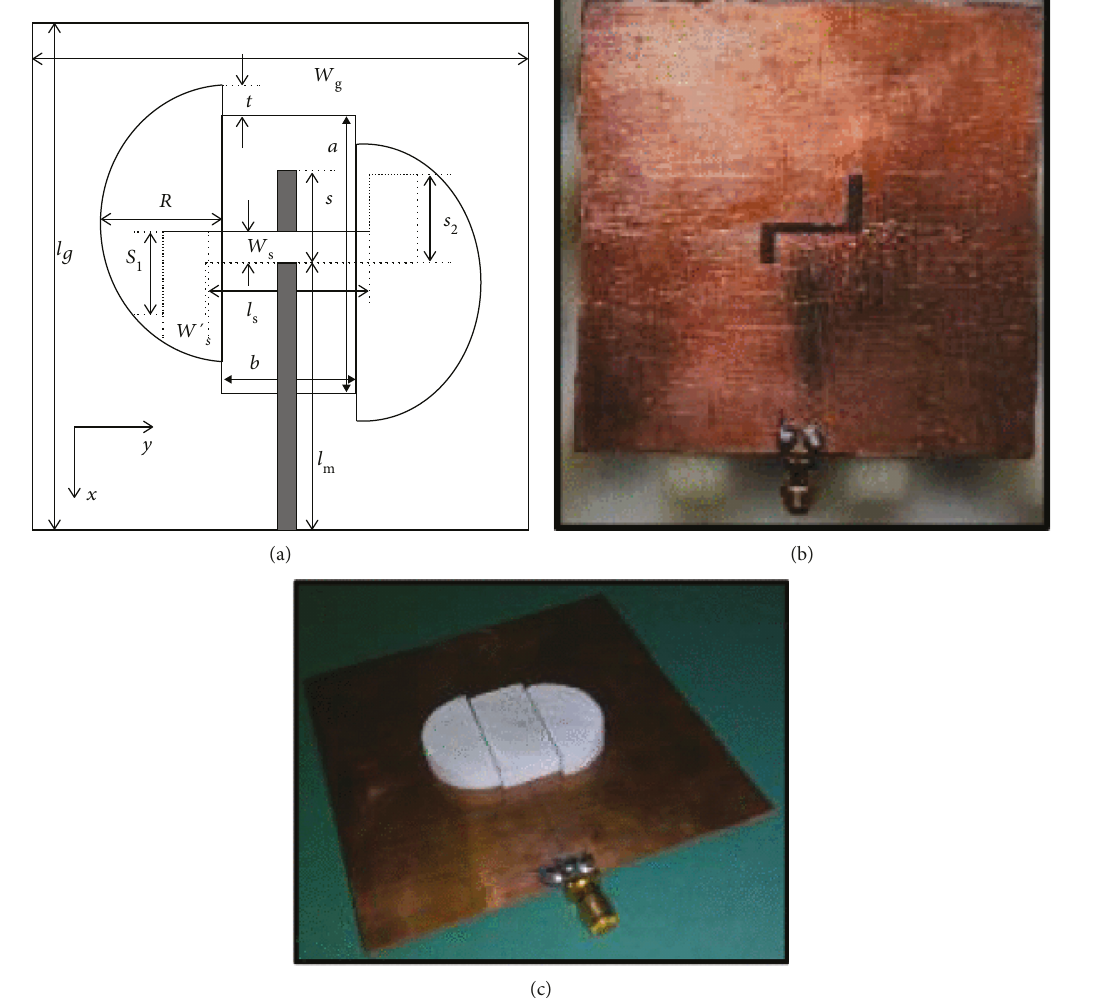
Figure 5: A circularly polarized (CP) single layer, and a single-feed planar slot antenna